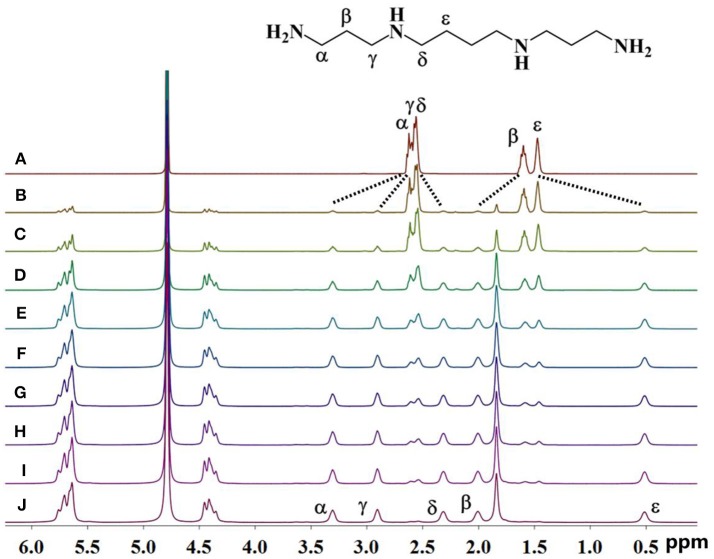
1H NMR spectra (400 MHz, D2O) of guest 1 without (A) and with (B) 0.10, (C) 0.18, (D) 0.25, (E) 0.39, (F) 0.58, (G) 0.67, (H) 0.78, (I) 0.98, and (J) 1.05 equiv. of TMeQ[6] (B–J).